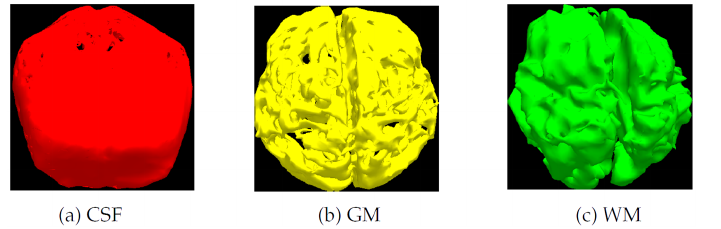
Figure 7. 3D visualization for the segmentation results.